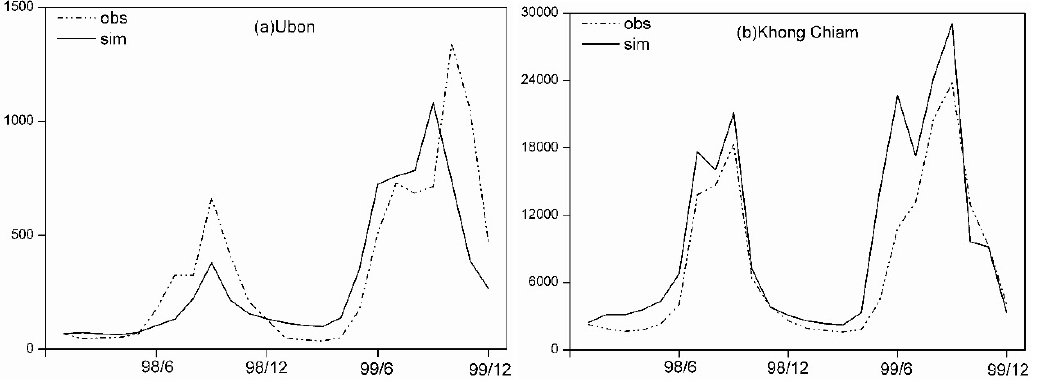
Fig. 4 Time series of monthly discharge driven by TRMM and GLDAS at Ubon (a) and Khong Chiam (b).